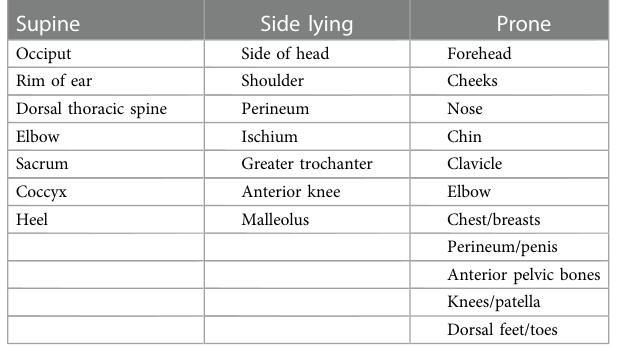
TABLE 6 Strategies to decrease pressure injury in critically ill patients.